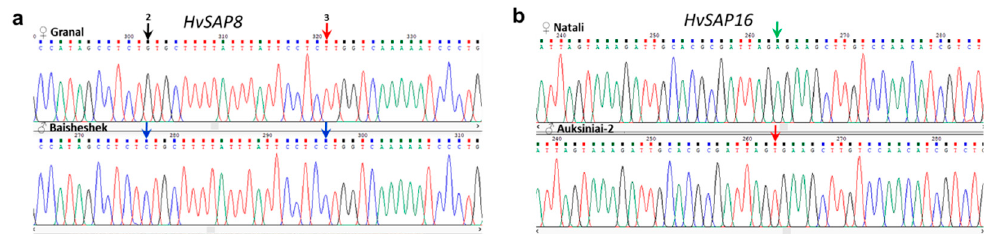
Figure 2. Comparison of sequence fragments of promoter regions of HvSAP8 ( a ) and HvSAP16 ( b ) in parents of barley hybrid populations, cultivars Granal, Baisheshes, Natali and Auksiniai-2, respectively. SNPs are indicated by arrows with corresponding colour. Order numbers were used for two SNPs in HvSAP8 while only a single SNP in HvSAP16 was found.